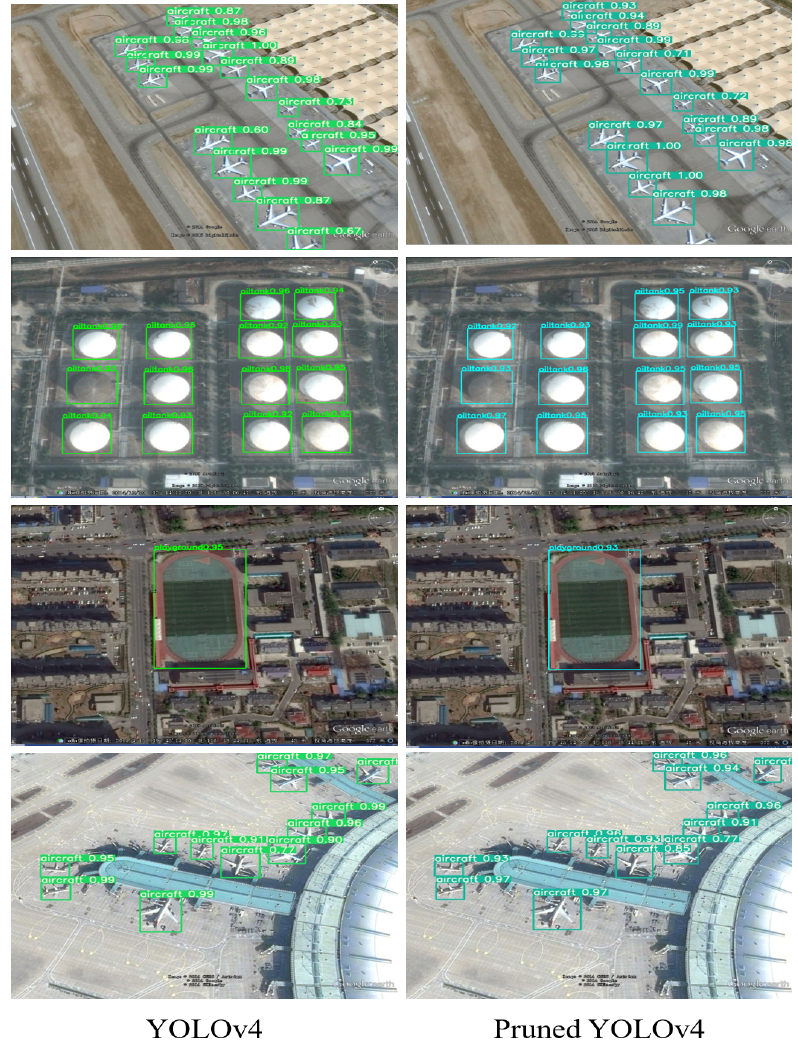
Figure 11. Visual detection results of YOLOv4 and the pruned YOLOv4.